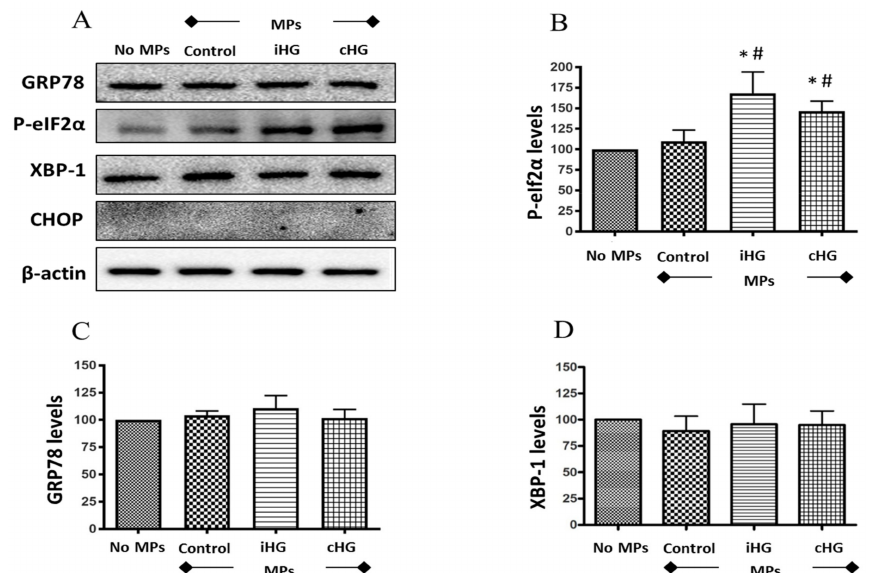
Figure 4. High glucose-derived microparticles (MPs; 10 µ g / mL) induce phosphorylation of eIF2 α in naïve renal proximal tubular cells. ( A ) Representative Western blots of endoplasmic reticulum (ER) stress markers - GRP78, P-eIF2 α , XBP-1, and CHOP; and ( B – D ) densitometry analyses of P-eIF2 α , GRP78, and XBP1 levels normalized to β -actin. Values were expressed as mean ± SEM; n = 3; * p < 0.05 versus no MPs (control); # p < 0.05 versus control MPs; GRP78: Glucose-regulated protein 78; P-eIF2 α : Phosphorylated-eukaryotic initiation factor 2 α ; XBP-1: X-box binding protein 1; CHOP: CCAAT-enhancer-binding protein homologous protein; iHG: Intermittent high glucose; cHG: Continuous high glucose.